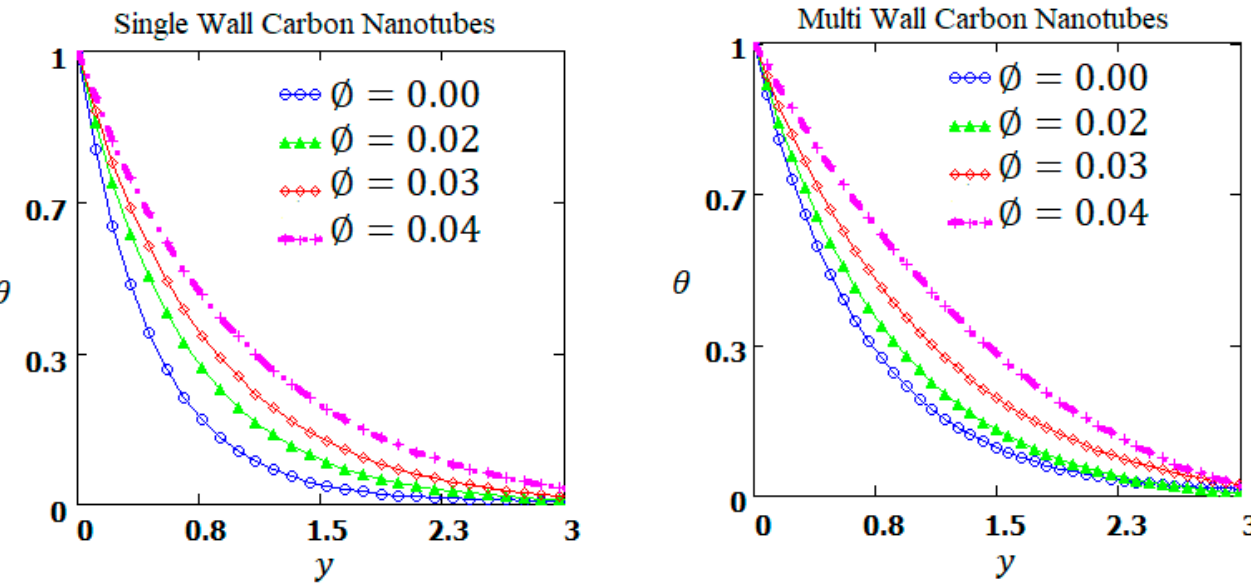
Figure 6. Temperature distribution of single and multi-wall carbon nanotubes without ripple visualizations for 2-D graphs subject to varying volume fraction.